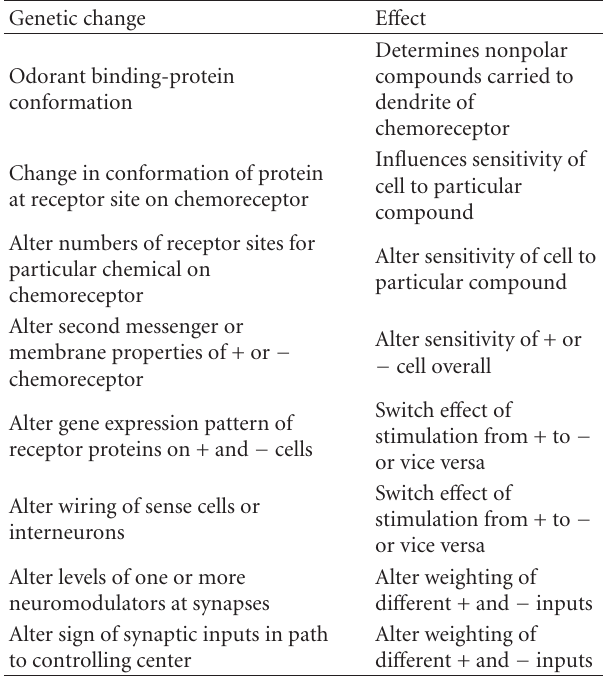
Table 2: Changes to olfactory system that can potentially a ff ect the behavioral orientation of insects to